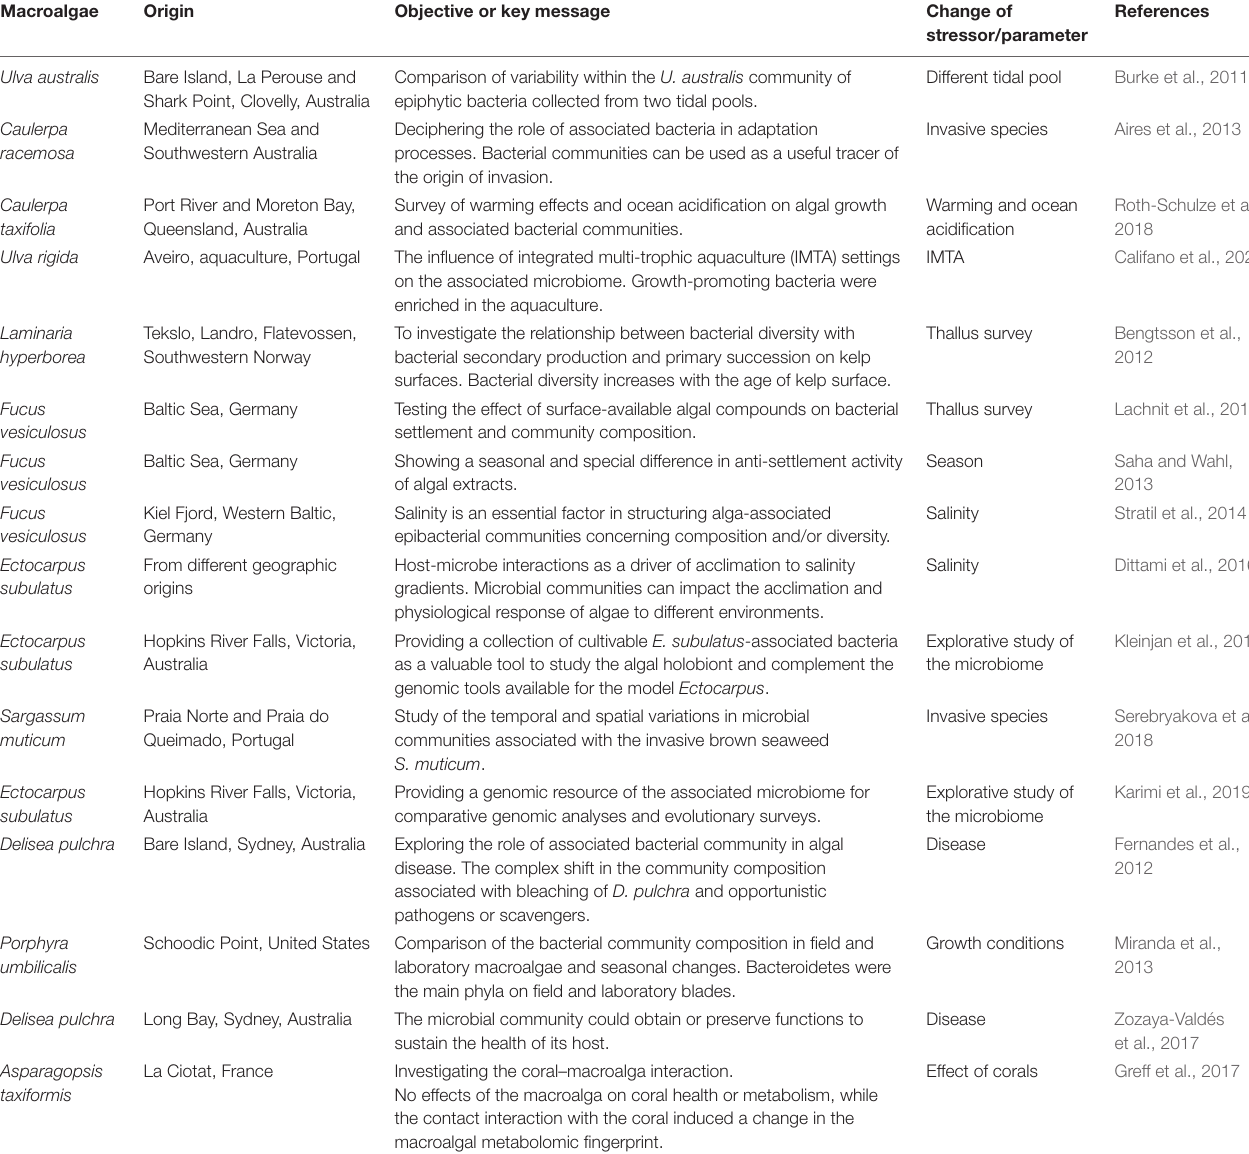
TABLE 1 | Exemplary microbiome studies of green, brown, and red macroalgae sorted